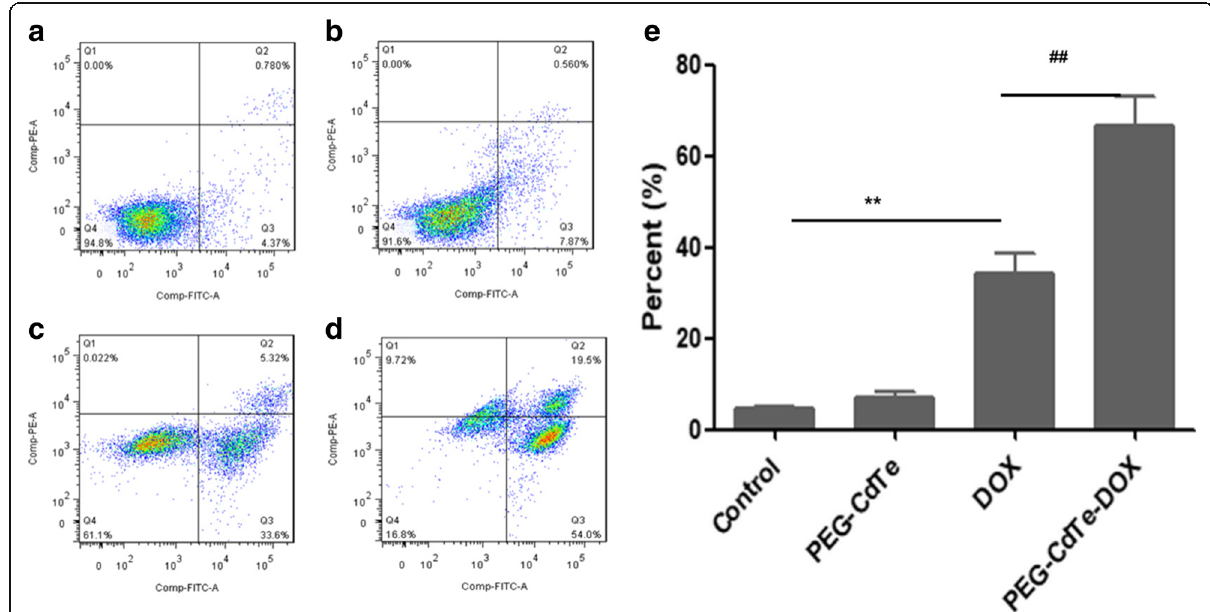
Fig. 5 Apoptosis rates of PRMI 8226 cells with different treatments. Notes: a PBS; b PEG-CdTe; c DOX; d PEG-CdTe-DOX. e Comparative apoptosis